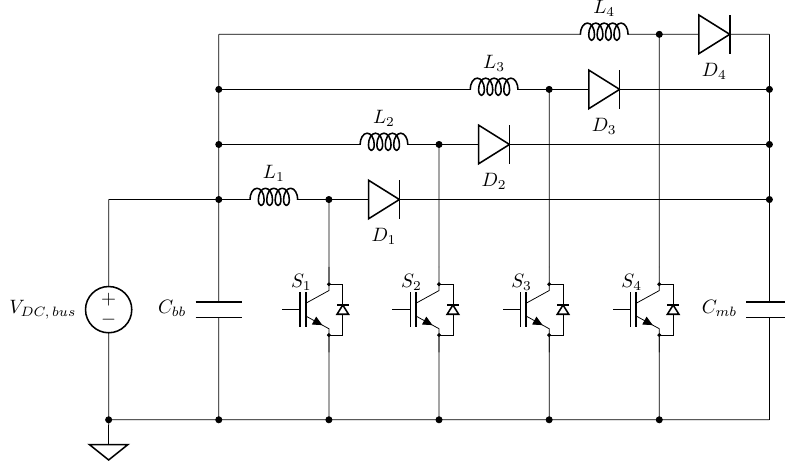
Figure 31. Simplified circuit diagram of the UW HiPeR-PIT PPU designed to enable thruster operation at repetition rates from 1kHz to